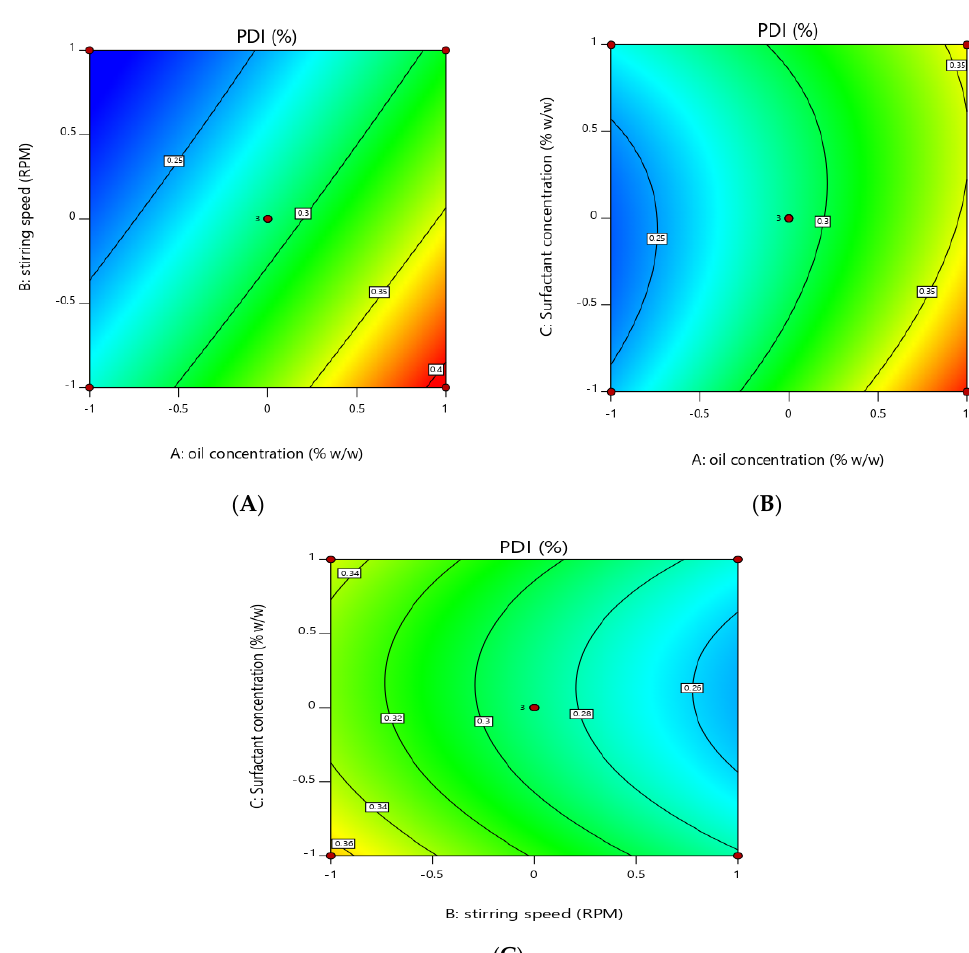
Figure 4. Contour graph showing effect of independent variables on PDI (Y2). ( A ) effect of oil concentration and stirring speed on PDI. ( B ) surfactants concentration and oil concentration on PDI. ( C ) effect of stirring speed and surfactant concentration on PDI.